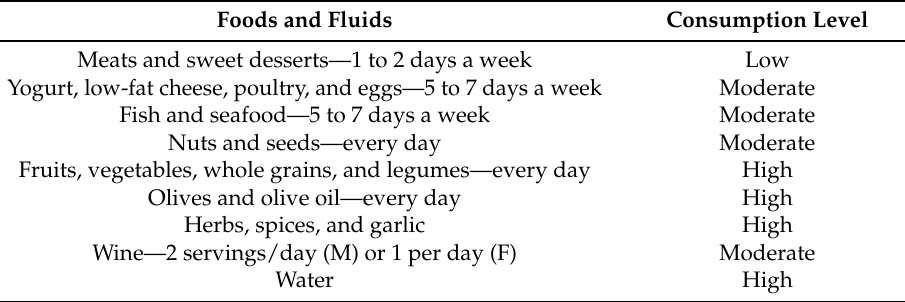
Table 1. Mediterranean food and fluid guide (pyramid)